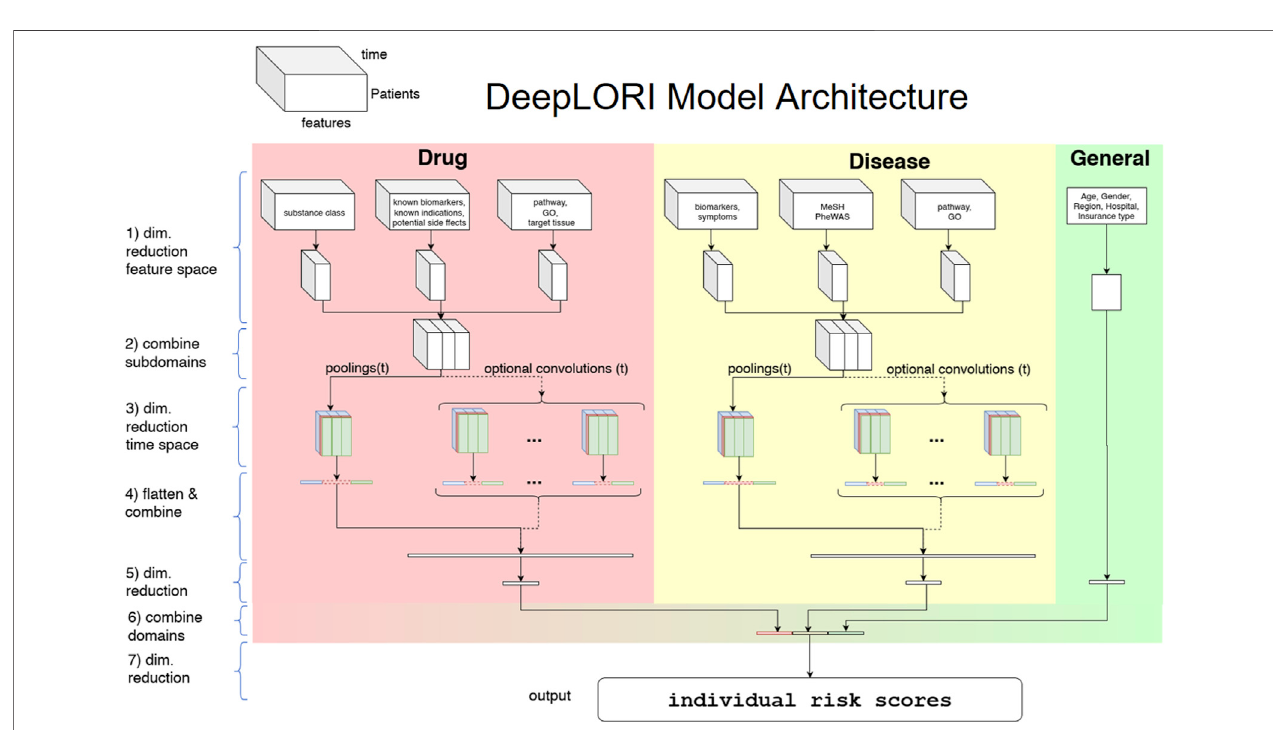
FIGURE 2 | DeepLORI model architecture: The input is organized as a multimodal data cube, which is subdivided into several feature domains. Medication and diagnosis-related features aretime-dependent,whereasfeatures inthe “ general ” domain arenot.Thethreedifferentcolorsat stage(3)symbolizethe3differentpooling/ convolution kernel